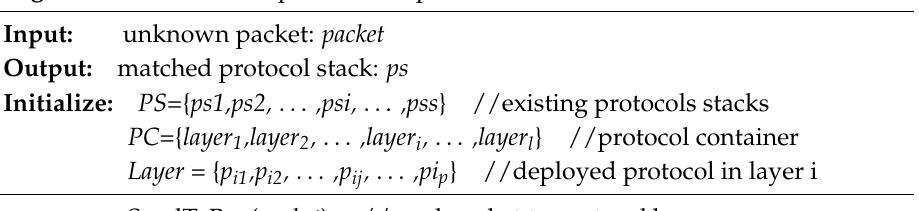
Algorithm 1. Automatic protocol